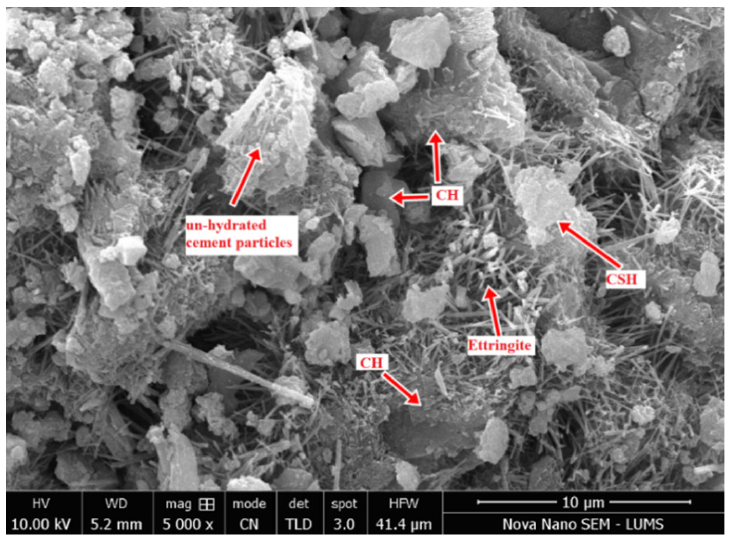
Figure 9. Micrograph of the pristine mortar sample .